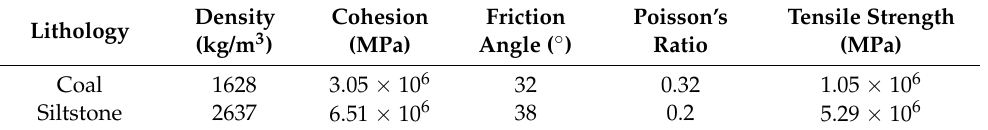
Table 3. Physical and mechanical parameters.